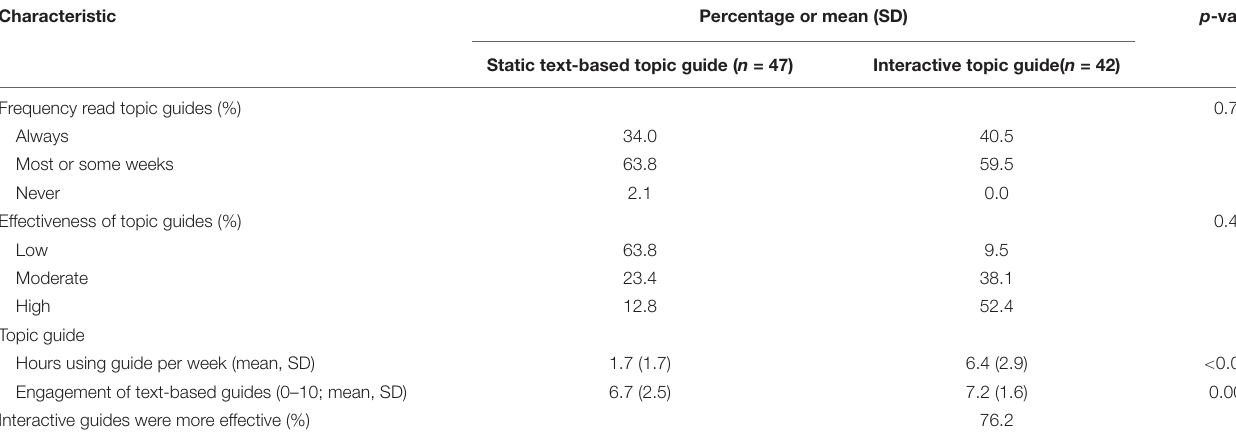
TABLE 1 | Participant engagement with online static text-based topic guides and online interactive topic guides. Characteristic Percentage or mean (SD) p -value Static text-based topic guide ( n =